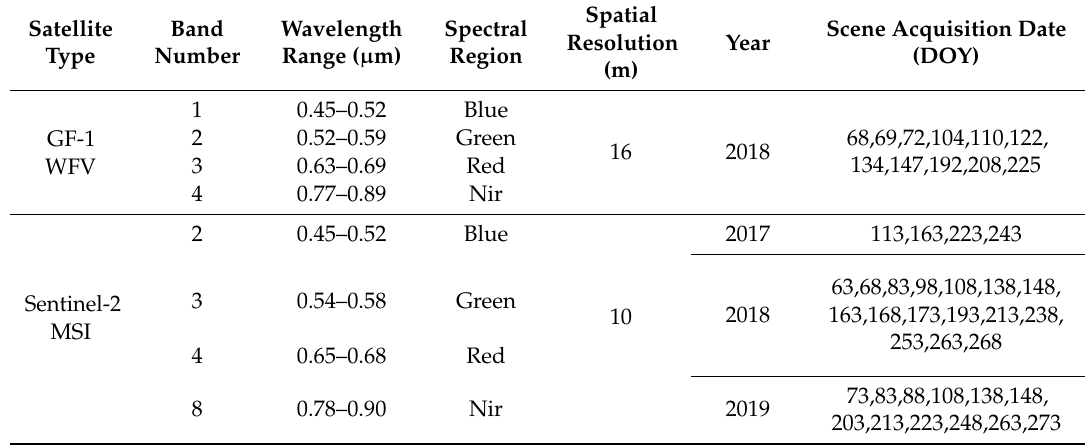
Table 1. Satellite image parameters of the research area.